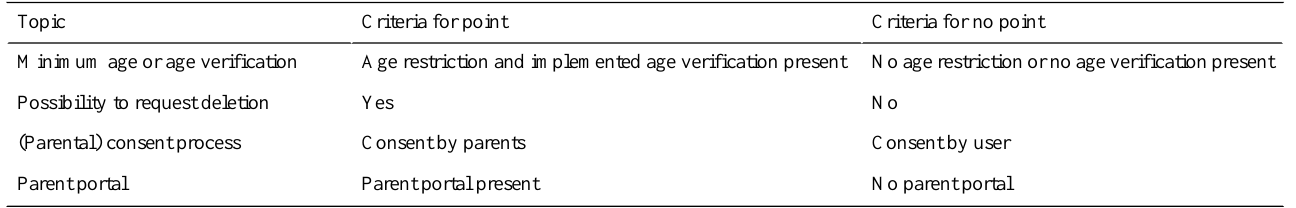
Table 3. Constraints of the scoring system.